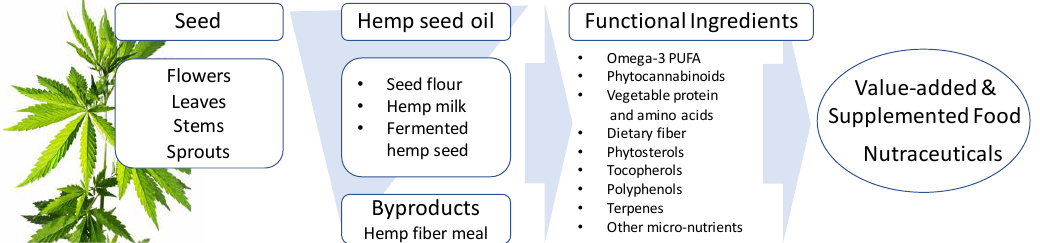
Figure 3. Advanced value-added technologies can drive value-added innovation to make use of industrial hemp to introduce a wide array of functional food ingredients and nutraceuticals.